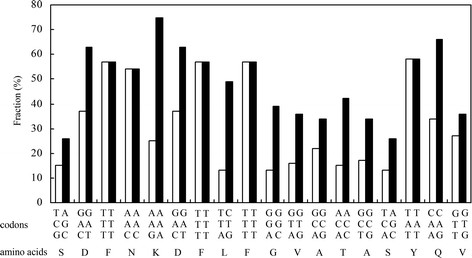
The codons for the amino acid between the 1stand 19thwhich were subjected to site-directed mutagenesis. Original sequence of the BGL (open square); optimal sequence of the BGL (filled square).